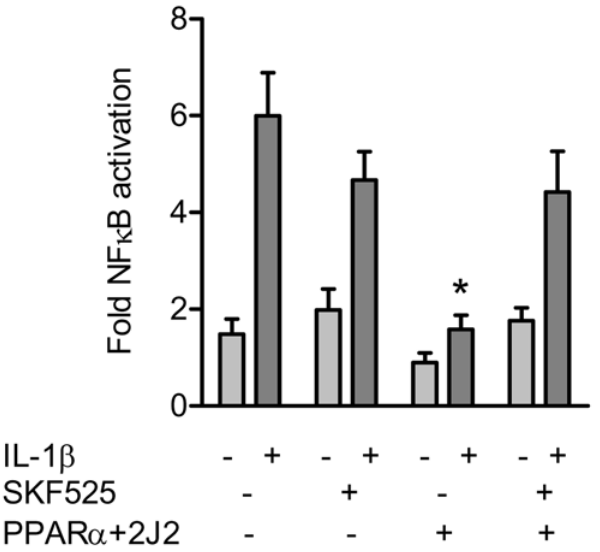
Figure 3. CYP2J2 activates PPAR a to inhibit NF k B activation. IL- 1 b (10 ng/ml; 20 h) induced NF k B reporter gene activation in HEK293 cells. Cells co-transfected with CYP2J2 and PPAR a abolished IL-1 b - induced NF k B activation. Co-incubation of cells with the epoxygenases